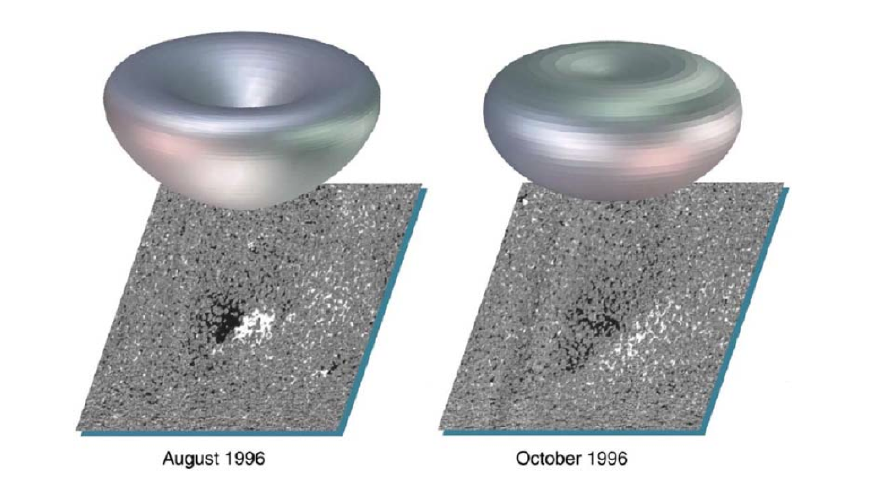
Figure 21: Three-dimensional rendering of the angular distribution of the development of the excess irra- diance emitted at 500 nm by AR 7978 at two stages, in the region’s 3rd and 5th rotation. The brightening caused by the growing facular region is more uniform later in the decay phase. The magnetograms at the time of the central meridian passage of the AR are from MDI. Image reproduced by permission from Ortiz (2003); see also Ortiz et al.